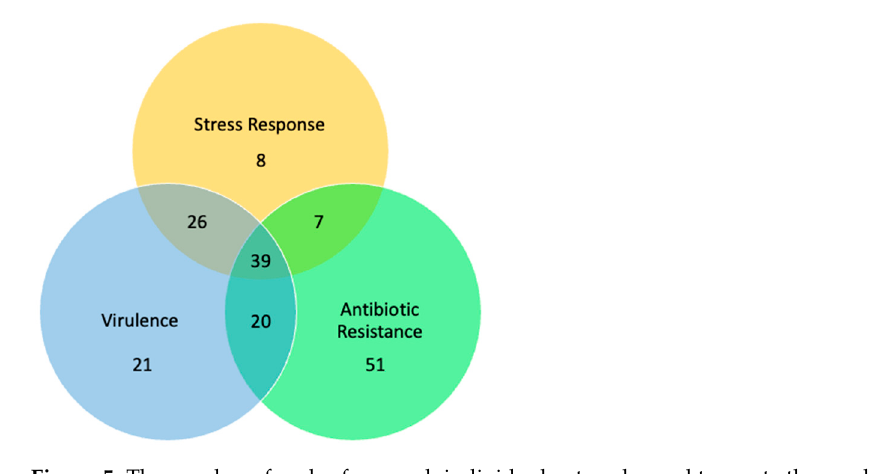
Figure 5. The number of nodes from each individual network, used to create the combined network.